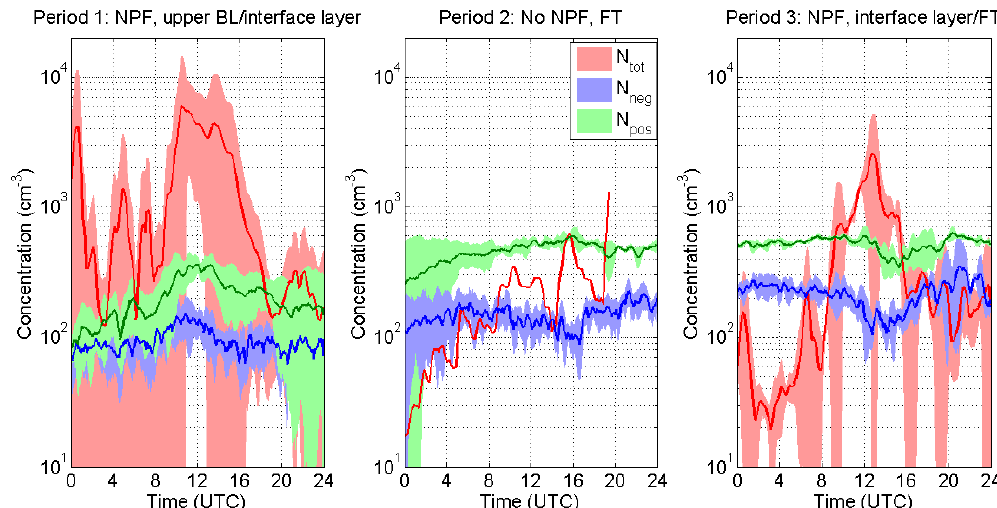
Figure 4. Mean diurnal variation of positive ( N pos ) , negative ( N neg ) and total ( N tot ) clusters (1 to 2.5nm mobility diameter) during the three sub-periods. Lower and upper limits of the shaded areas represent the standard deviation of the corresponding concentration. On non-event days, the lack in total cluster concentration measurement is due to an instrument failure. The occurrence of NPF during the sub-periods as well as the location of the station during nucleation hours are indicated at the top of the figure. February 2012, Puy de